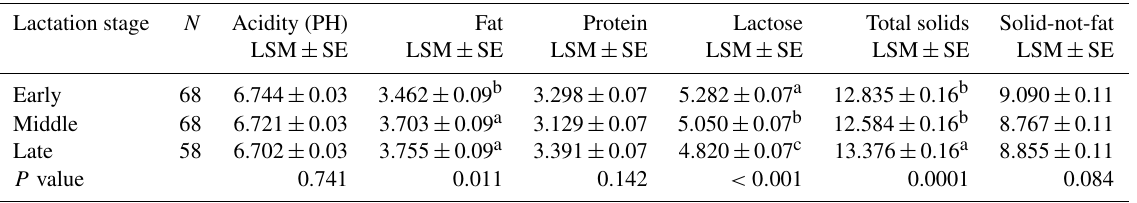
Table 4. Effect of lactation stage on milk chemical compositions (%) in Maghrebi camels. Lactation stage N Acidity